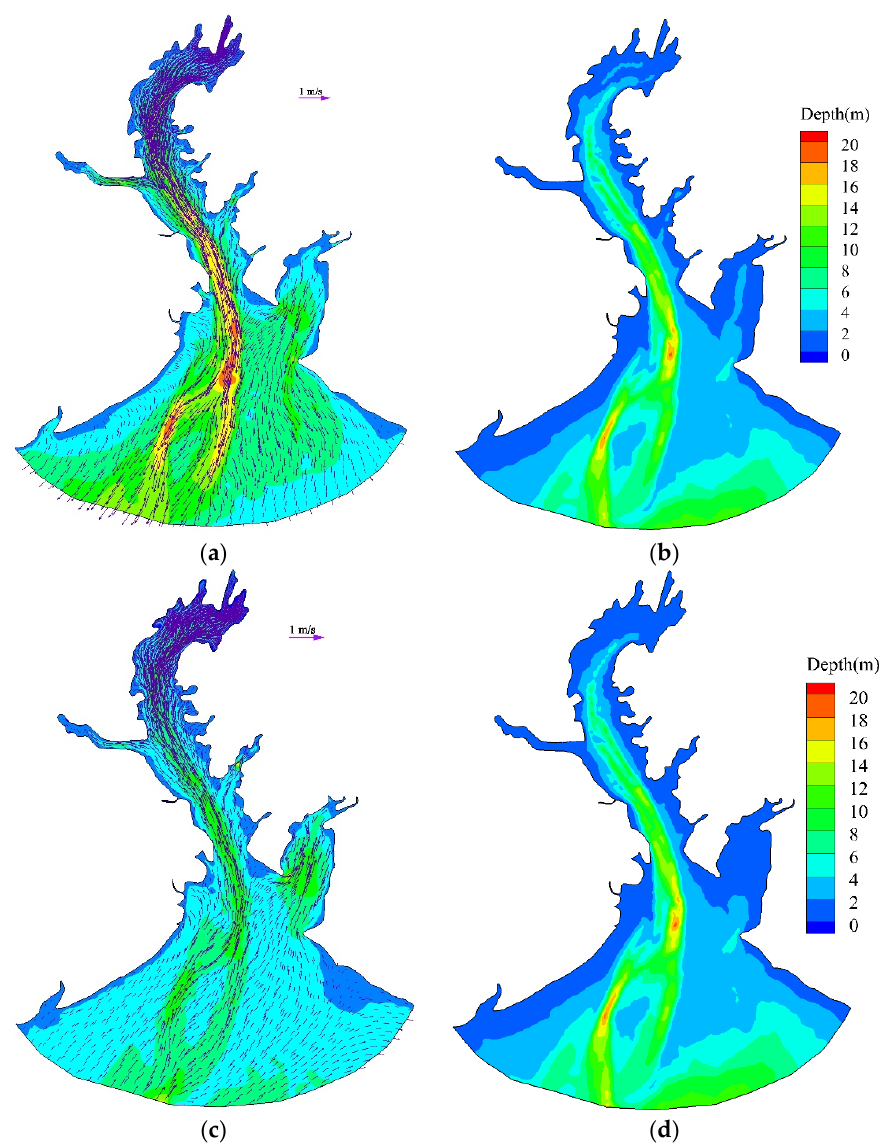
Figure 6. Spatial distributions of water velocities: ( a ) ebb current; ( c ) flood current; and corresponding water depths: ( b ) ebb current; ( d ) flood current.